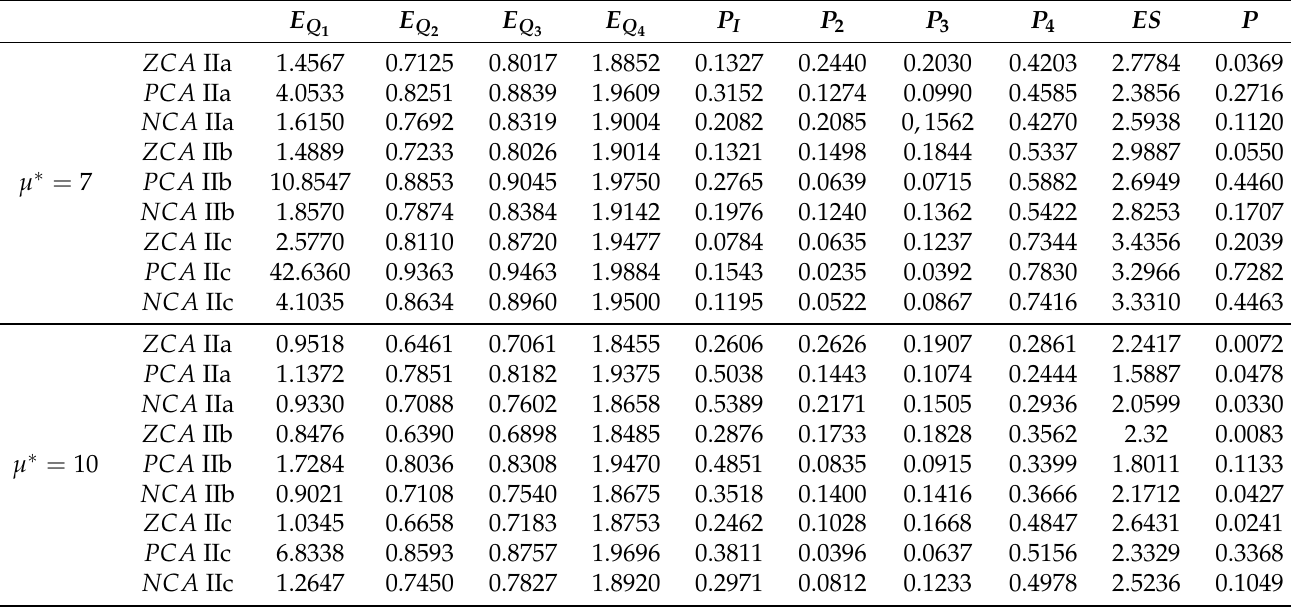
Table 12. Measures for various combinations of arrival and service processes—Scenario